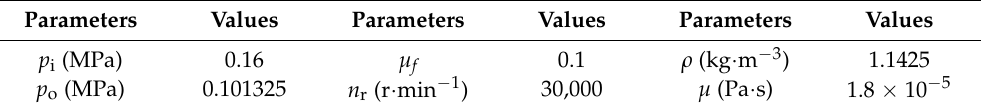
Table 2. Operating